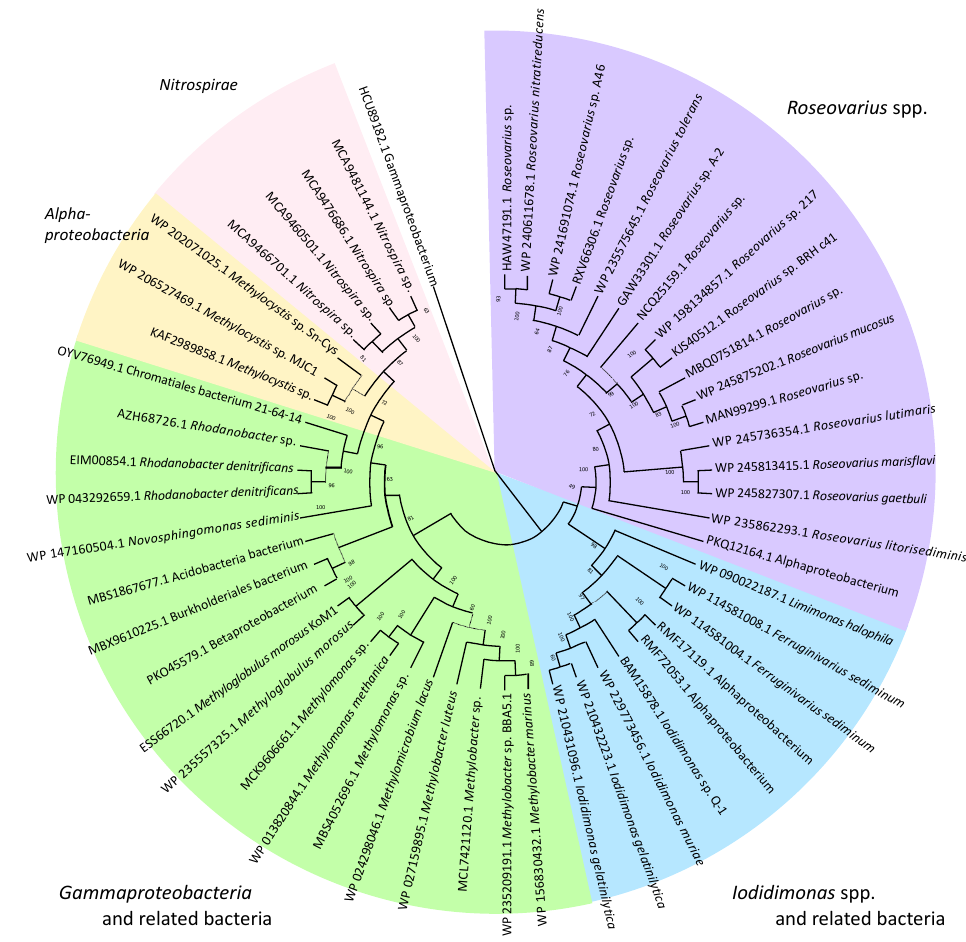
Figure 3. Neighbor-joining phylogenetic tree of IoxA and related proteins.